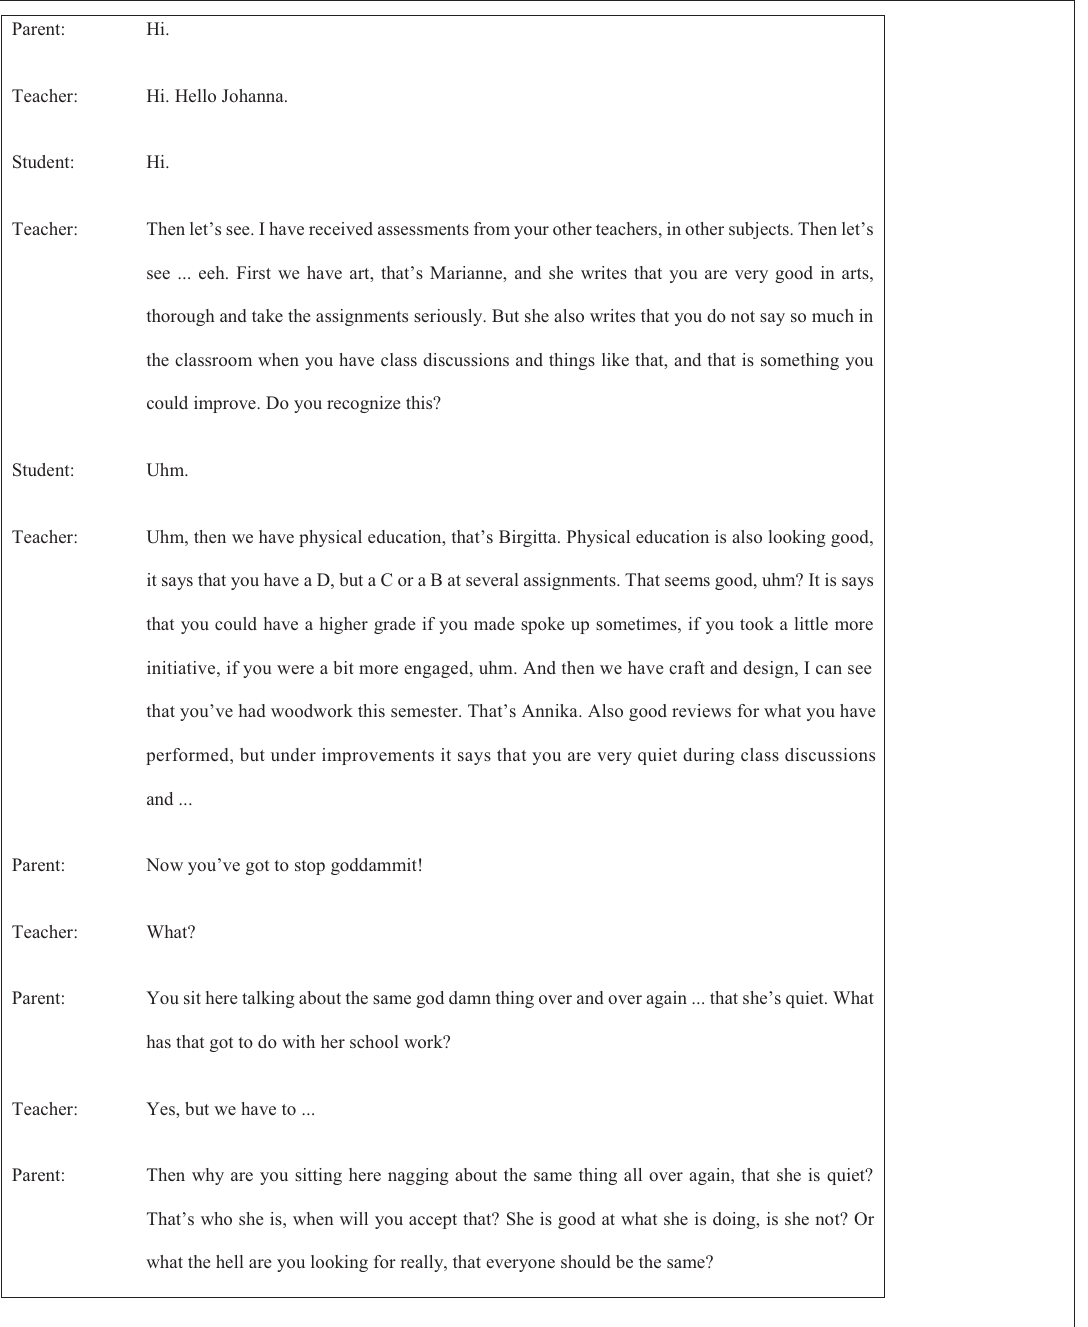
FIGURE 1 | Transcript from the movie that the preservice teachers analyzed.